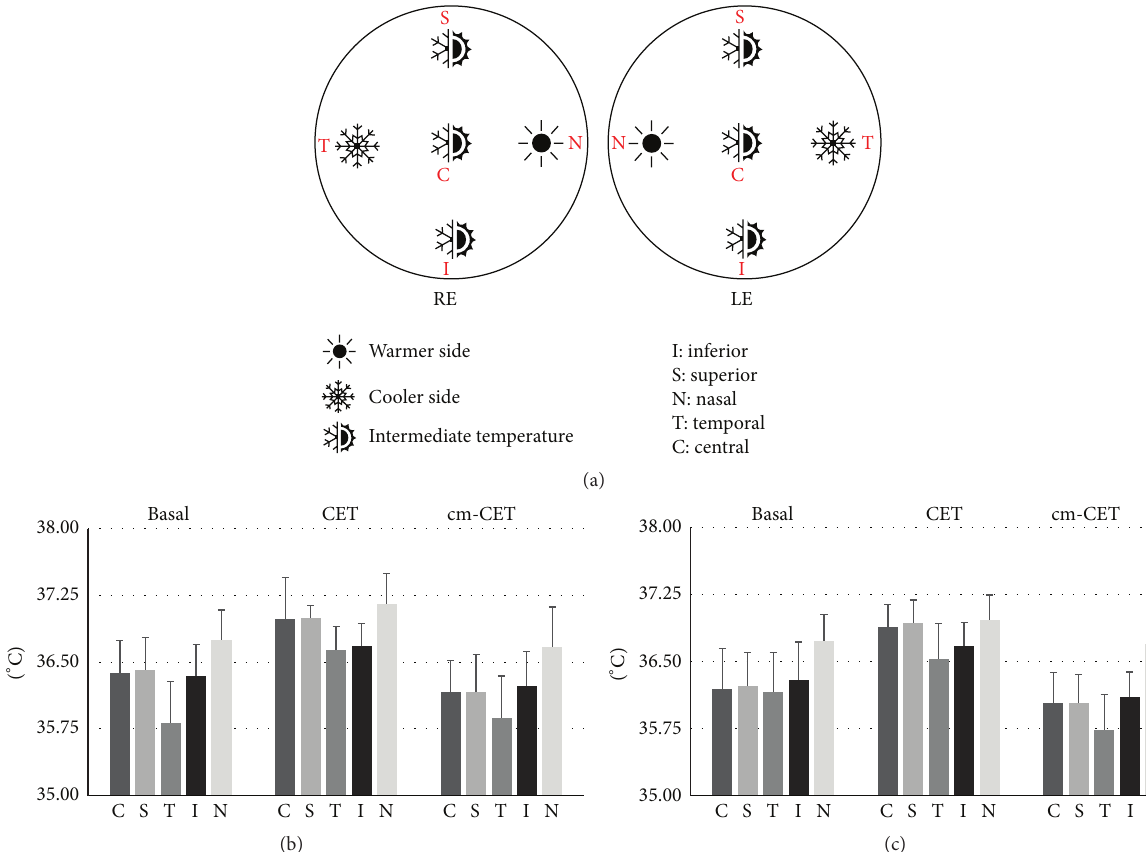
Figure 1: (a) A graphic illustration of the distribution of temperature on the corneal surface. (b) and (c) Values of the temperature measured in the different areas of the cornea for the right (b) and left (c) eye with open eyelids (basal); after one hour with closed eyelids (CET) and after one hour with closed eyelids wearing a cooling mask